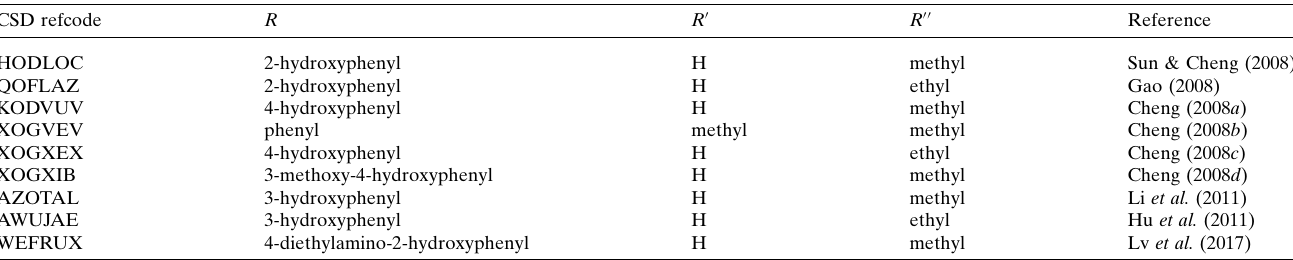
Table 4 A sample of structures similar to I and II in the CSD. R and R 0 represent groups attached at the equivalent of C4 and R 00 represents the group attached at the equivalent of O3.